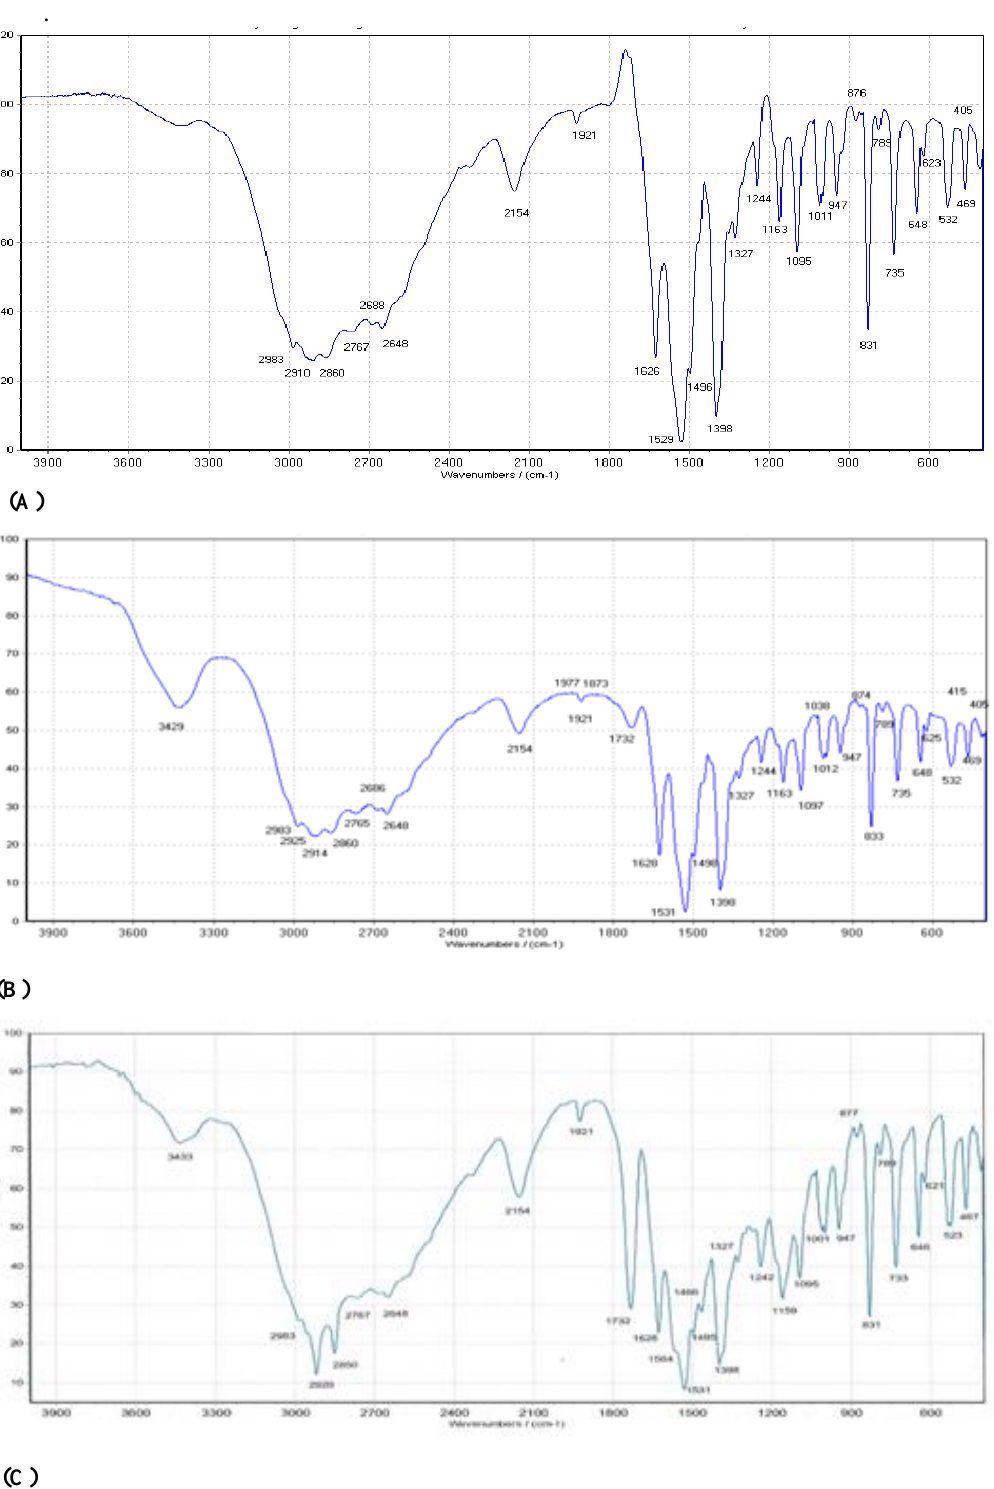
Figure ( 6) FTIR spectrum (A) Pure BFN, (B) Physical mixture ratio1:1 of BFN and